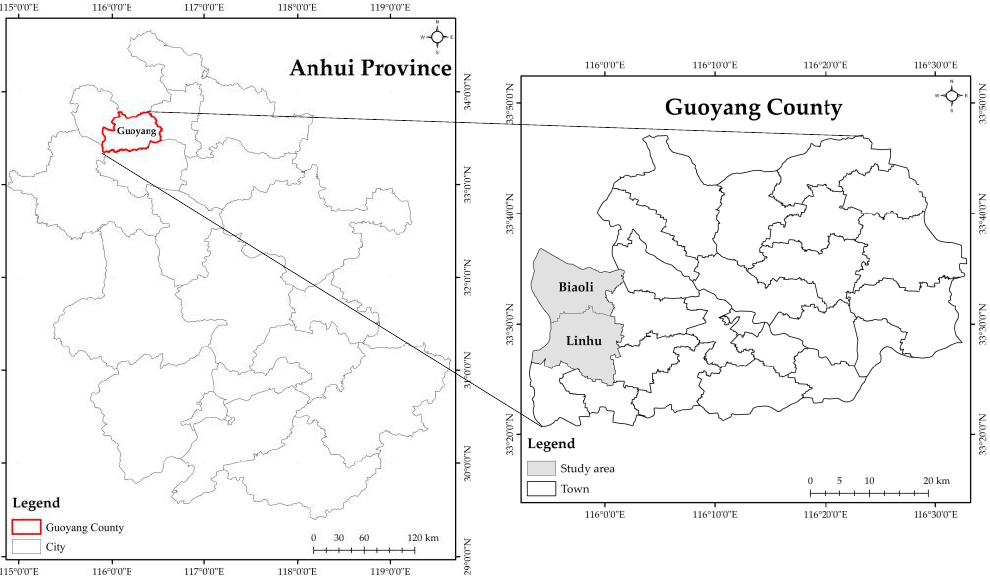
Figure 1. Geographic locations of Biaoli Town and Linhu Town, Guoyang County, Bozhou City, Anhui Province, China.